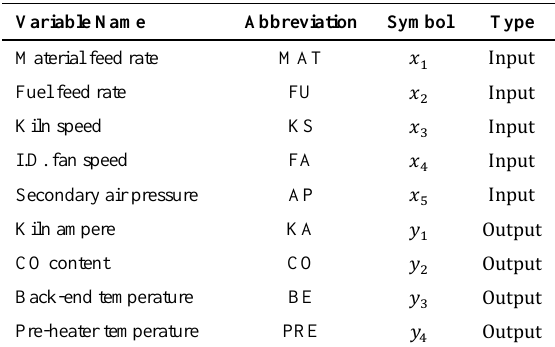
Table 1. Input and output variables in cement rotary